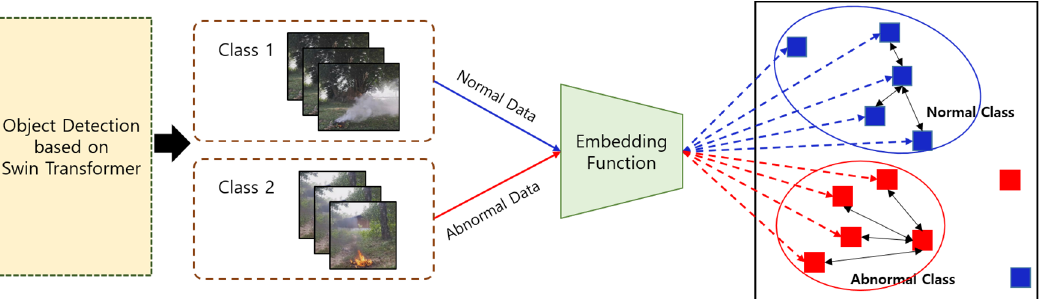
Figure 6. The structure of the Few ‐ Shot Learning ‐ based object detection mining.